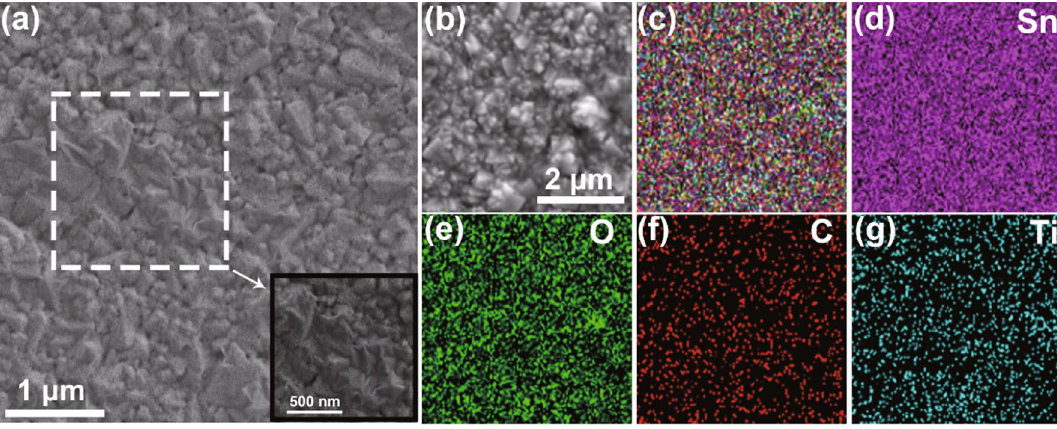
Fig. 2 a SEM image of MDCN film in top view, with enlarged image of dotted box region in inset. b SEM image of MDCN film in top view for EDS analysis, and c corresponding element layered image, with elemental mapping image of d Sn, e O, f C, and g